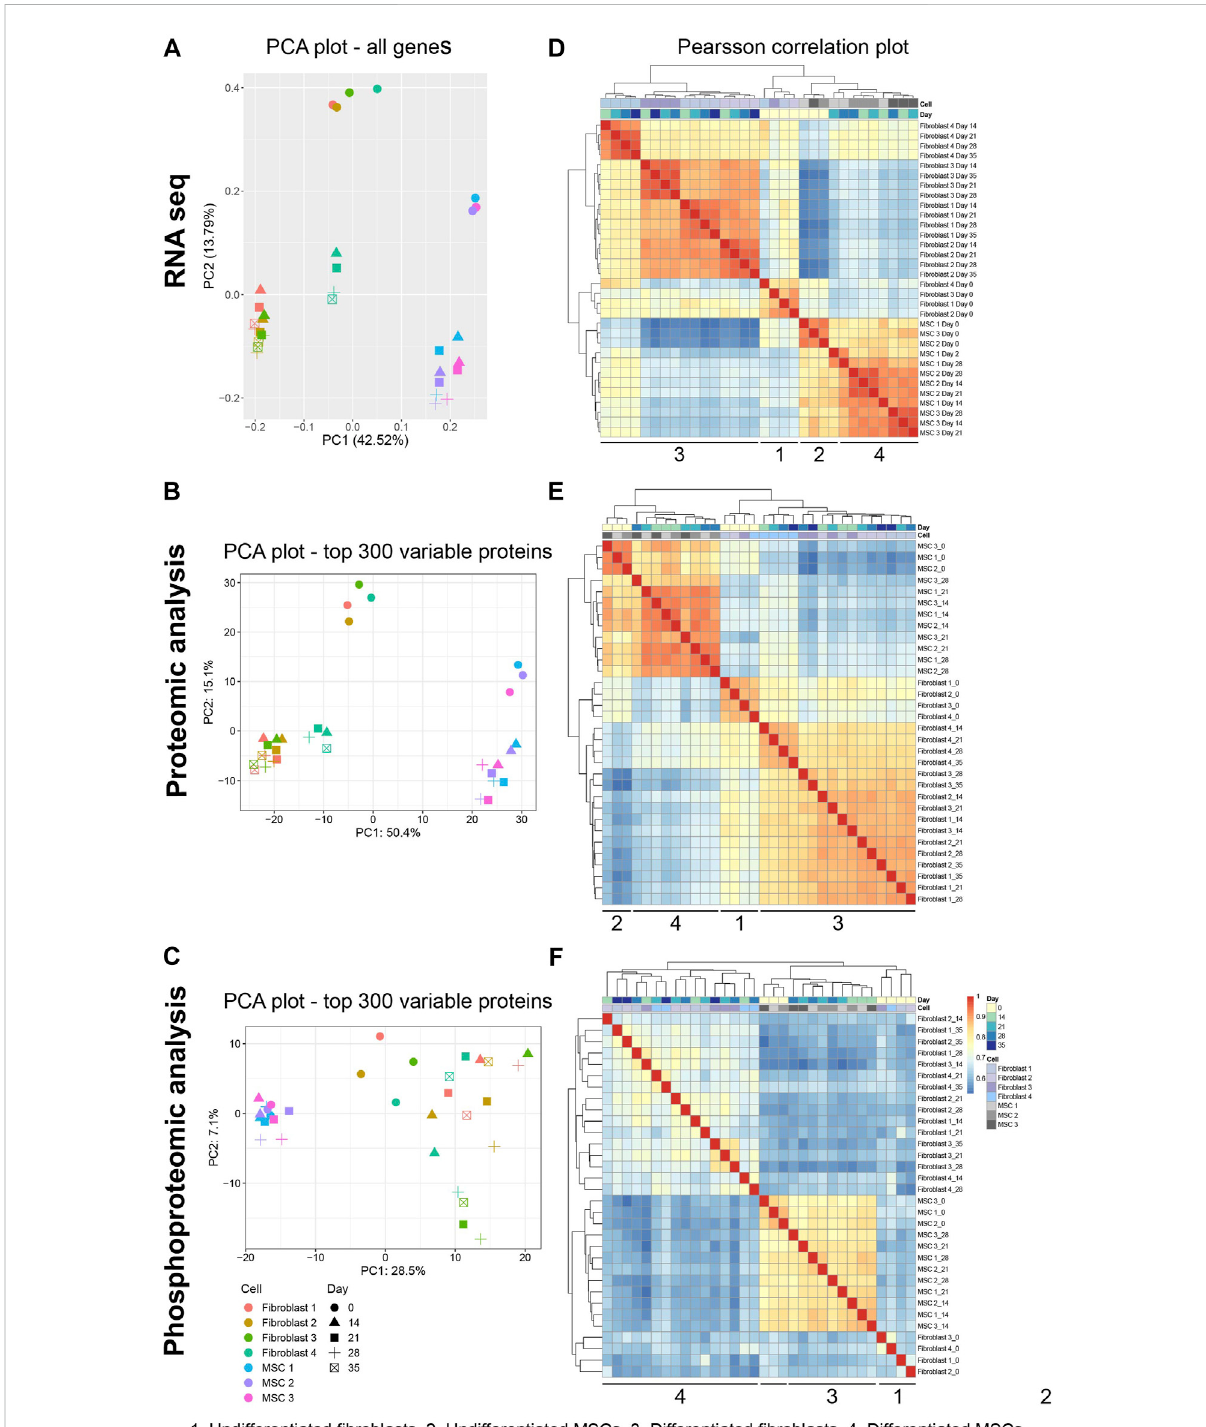
FIGURE 3 Assessing inter- and intragroup variability of fi broblasts and MSCs. Principal component analysis (PCA) plot visualized all 32 samples in the datasetfromallapproachesalongPC1andPC2. (A) RNA-seqdatadescribe42.52%(PC1)and13.79%(PC2)ofthevariabilityofallgenes. (B,C) Dataset from protein proteomic analysis describes 50.4% (PC1) and 15.1% (PC2) of variability while from phosphoprotein proteomic the variability was 28.5% (PC1) and 7.1% (PC2) in the top 300 proteins. (D – F) Between-sample correlations. Heat maps show the pairwise Pearson ’ s correlation coef fi cient.Thescalebarofthelegendsrepresentstherange ofthecorrelationcoef fi cientpresented.PCAofdatavisualizetheinter-andintragroup variabilitybetweenthe32samples(four fi broblastcelllinesat fi vetimepointsandthreeMSClinesatfourtimepoint).Pearson´scoef fi cient,describes the directionality and strength of the relationship between two